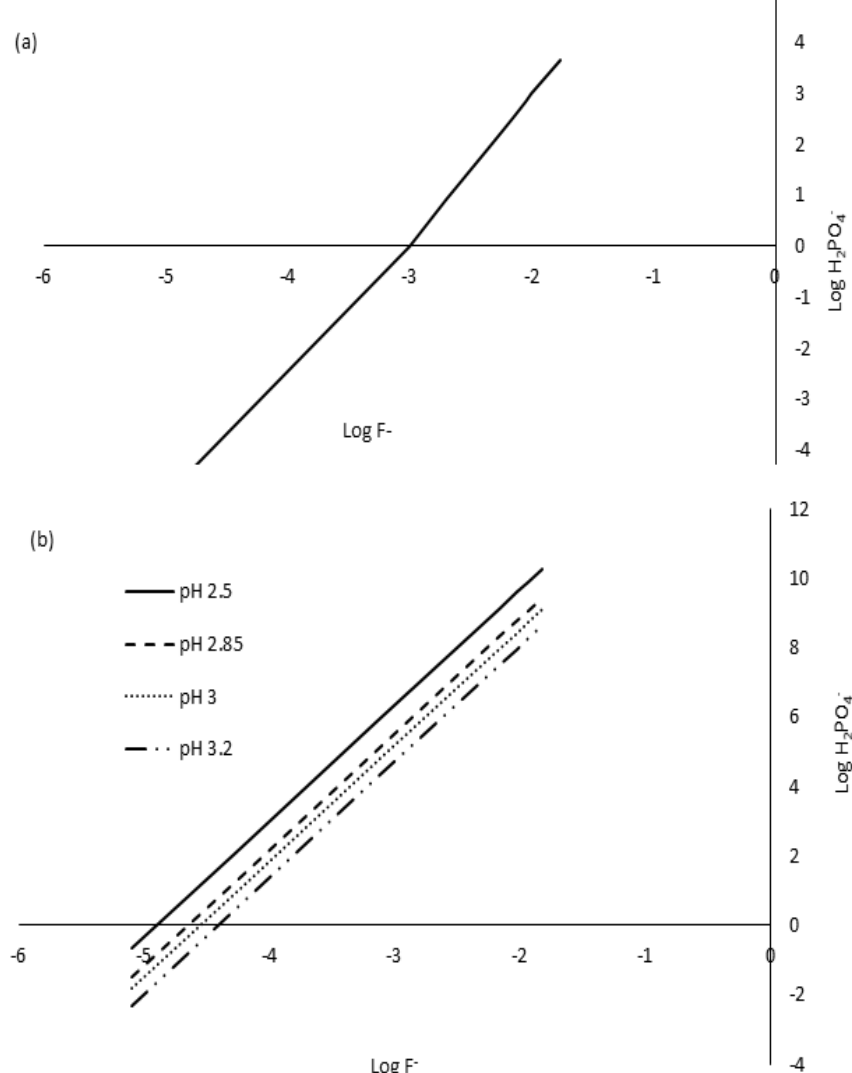
Figure 3. Solubility diagrams for ( a ) variscite and ( b ) hydroxyapatite (HAP) as a function of solution fluoride (F − ) concentration. Variscite-solution equilibria were calculated with consideration of Al-hydroxide and Al-F solution complex formation. All equilibrium constants were obtained from Lindsay [21].